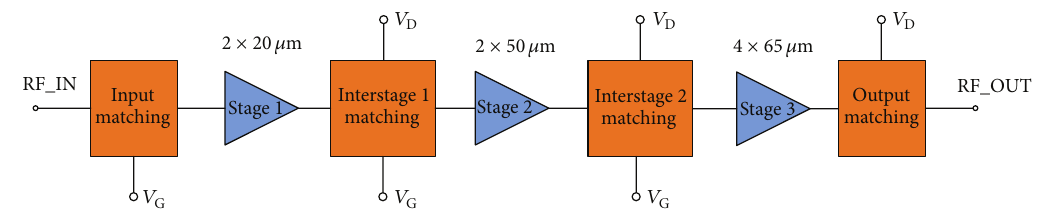
Figure 1: The block diagram of the proposed power amplifier.